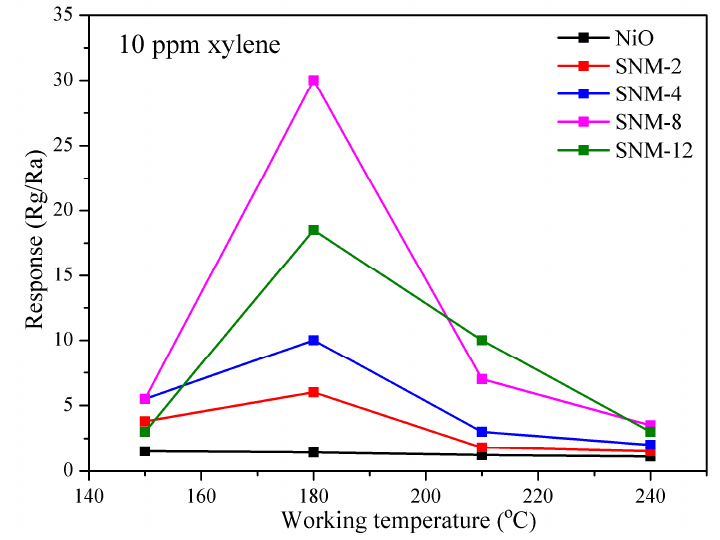
Figure 7. Gas responses of the NiO and SNM sensors toward 10 ppm xylene at different working temperatures.